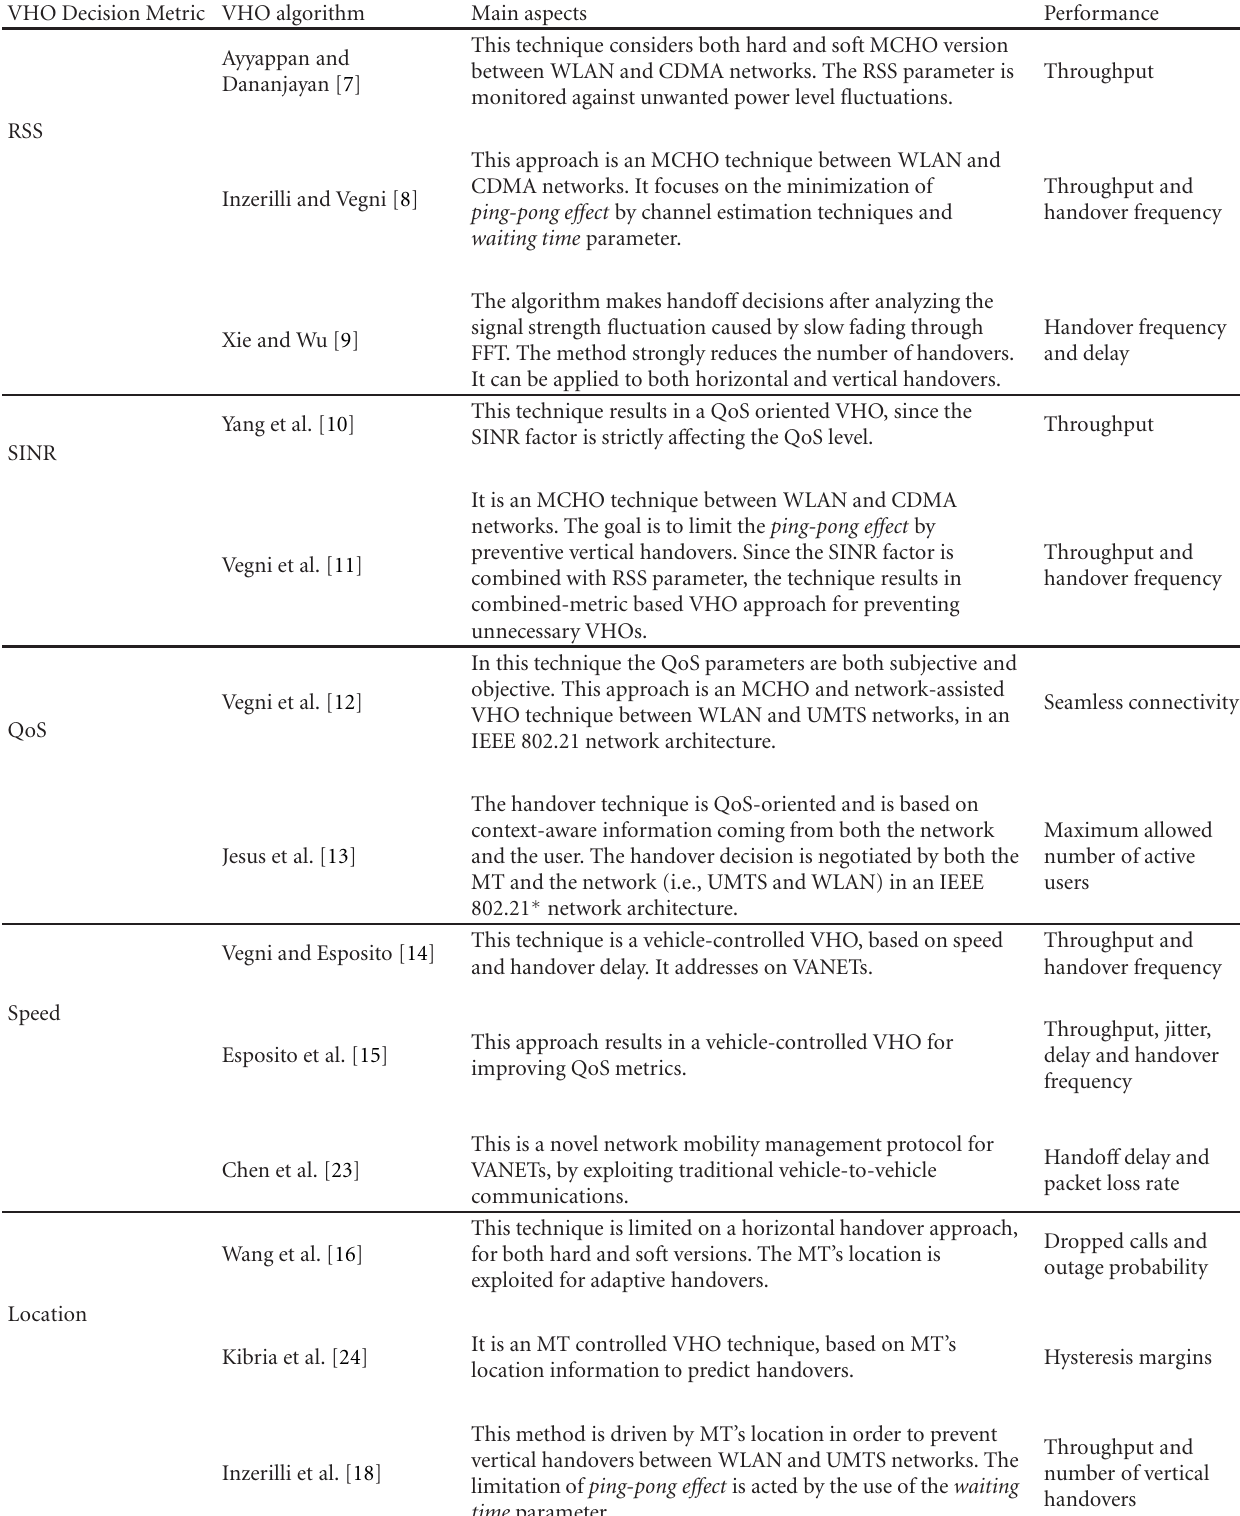
Table 1: Classification of handover algorithms on the basis of decision metrics and performance